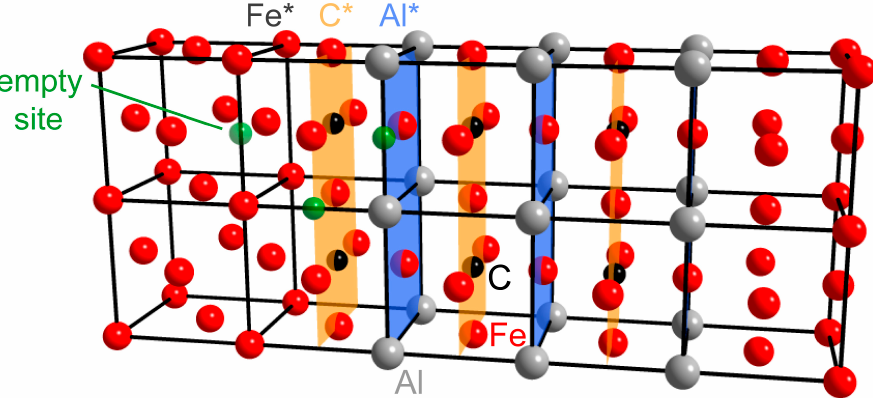
Figure 7. The 5 × 2 × 1 supercell composed of κ -carbide and fcc-Fe (assuming coherent interfaces) for a given thickness of the κ -phase. Orange planes, labeled C*, signify (100) layers containing C and Fe atoms, while blue planes, labeled Al*, contain Fe and Al. Layers containing Fe only are unmarked and labeled Fe*. The translucent green spheres represent empty octahedral sites which (in addition to C vacancies) may incorporate H atoms.